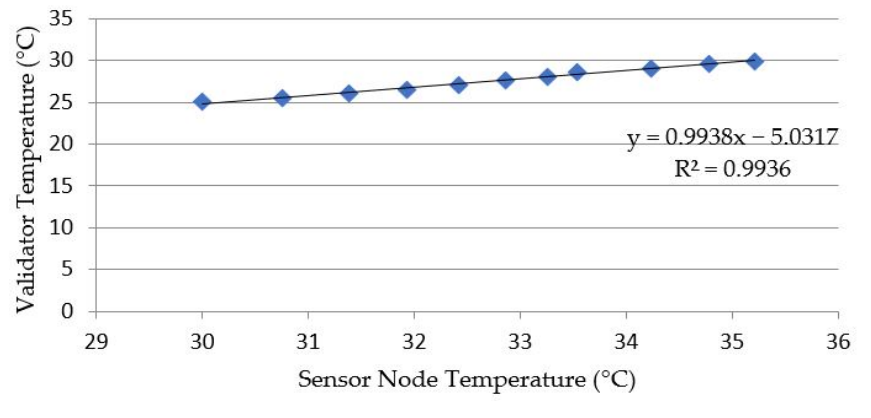
Figure 11. Temperature compensation calculation.